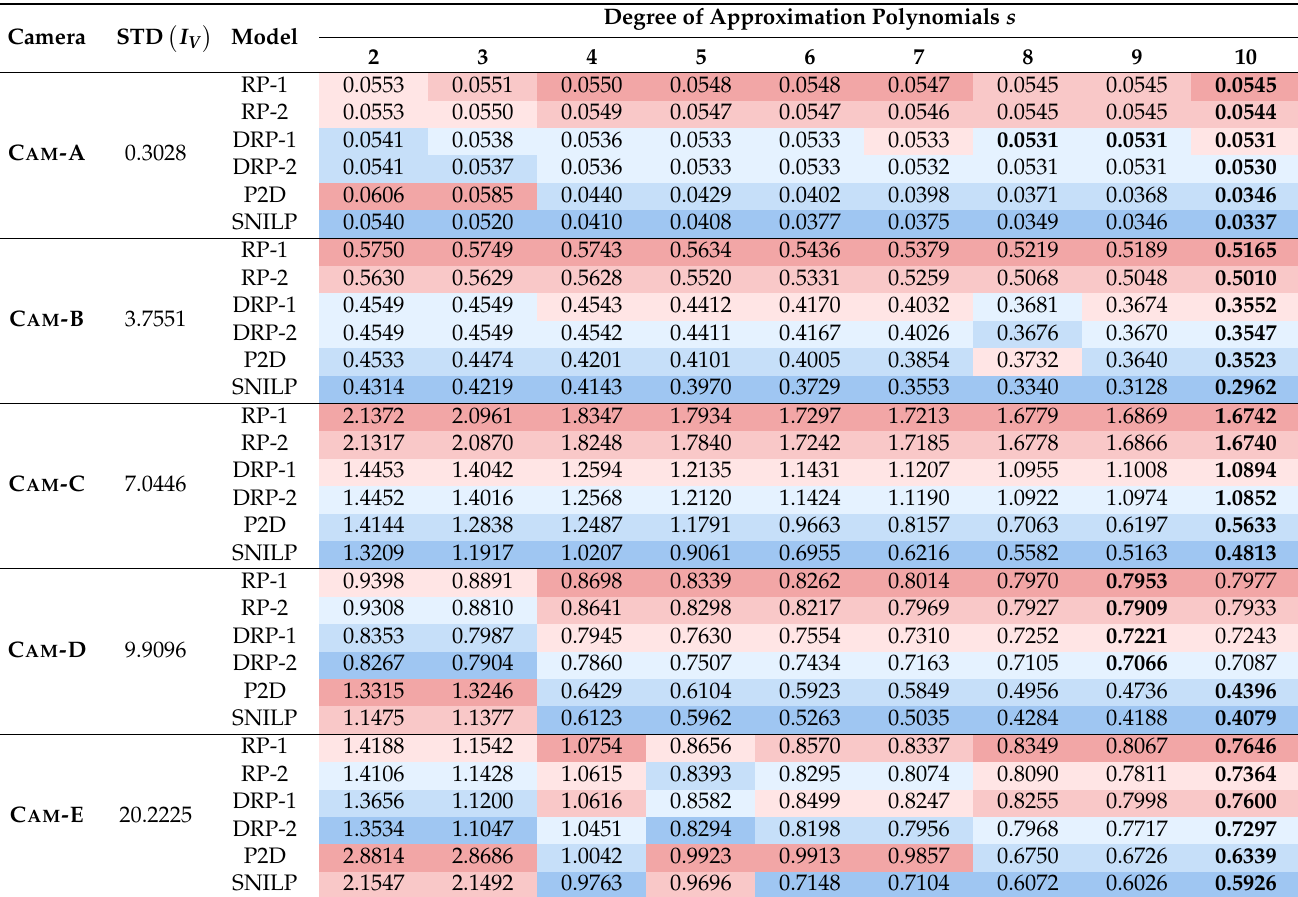
Figure 5. Comparison of the quality of the vignetting correction obtained for the compared vignetting models and used cameras. The values of measures of vignetting correction quality are presented in the relation to the initial values of the ( a ) STD and ( b ) IQR measures of the I V images obtained from the corresponding camera. (cid:0) (cid:1) I V (cid:101) V − 1 Table 3. Comparison of STD